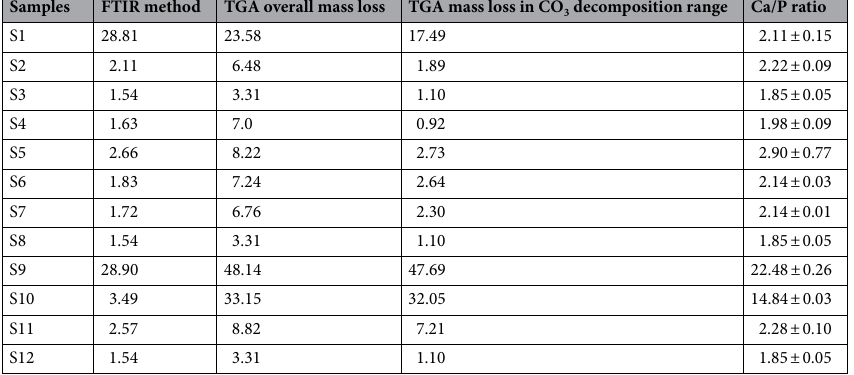
Table 2. Remaining carbonate content calculation using various